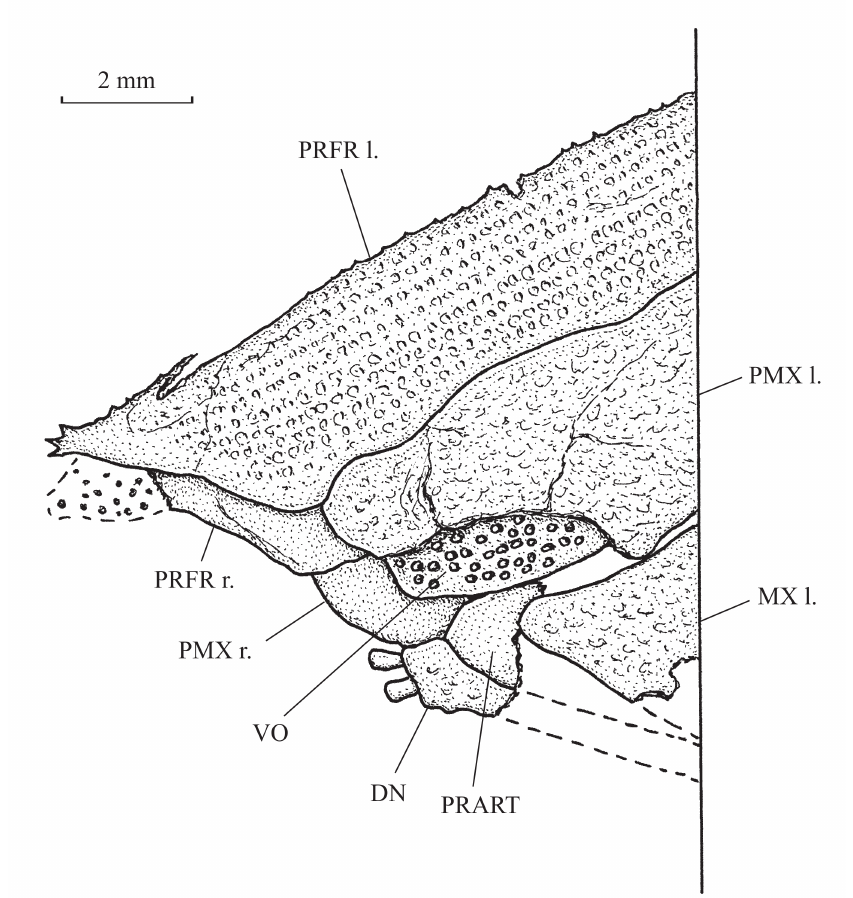
Fig. 7. Joinvillichthys lindstroemi (Davis, 1890). Vomerian region of sample